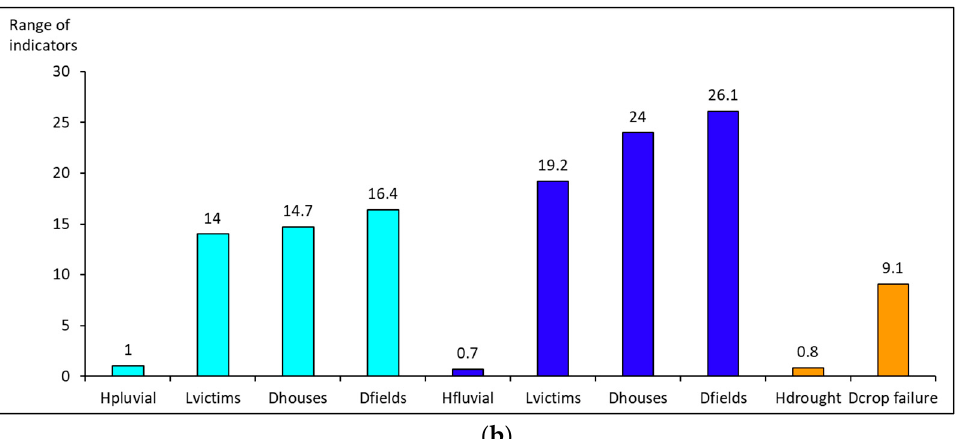
Figure 10. The importance of the single components of risk in the Dosso region according to threat, 2011–2017 ( a ) and the range of indicators of pluvial flooding, fluvial flooding, and drought risk ( b ) using data from Table 4. Table 4. Multihazard risk level at the municipal scale in the Dosso region, 2011–2017 (H-Hazard, D-Loss & Damage, R-Risk).